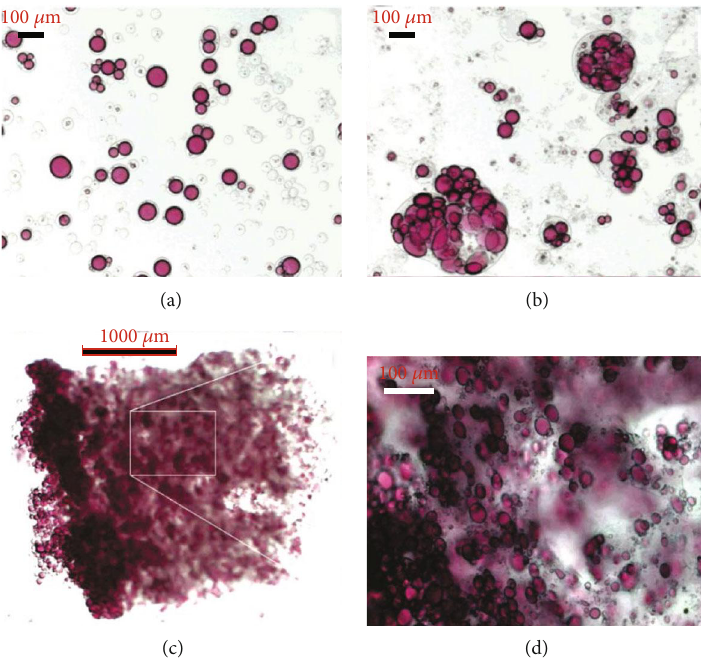
Figure 30: Recoacervation of heated microcapsules upon cooling [108].